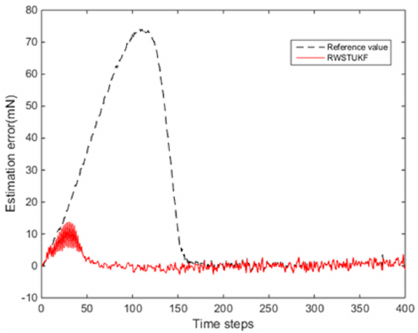
Figure 2. Estimation errors by both unscented Kalman filter (UKF) and random weighting strong tracking unscented Kalman filter (RWSTUKF) under the initial state estimation error.